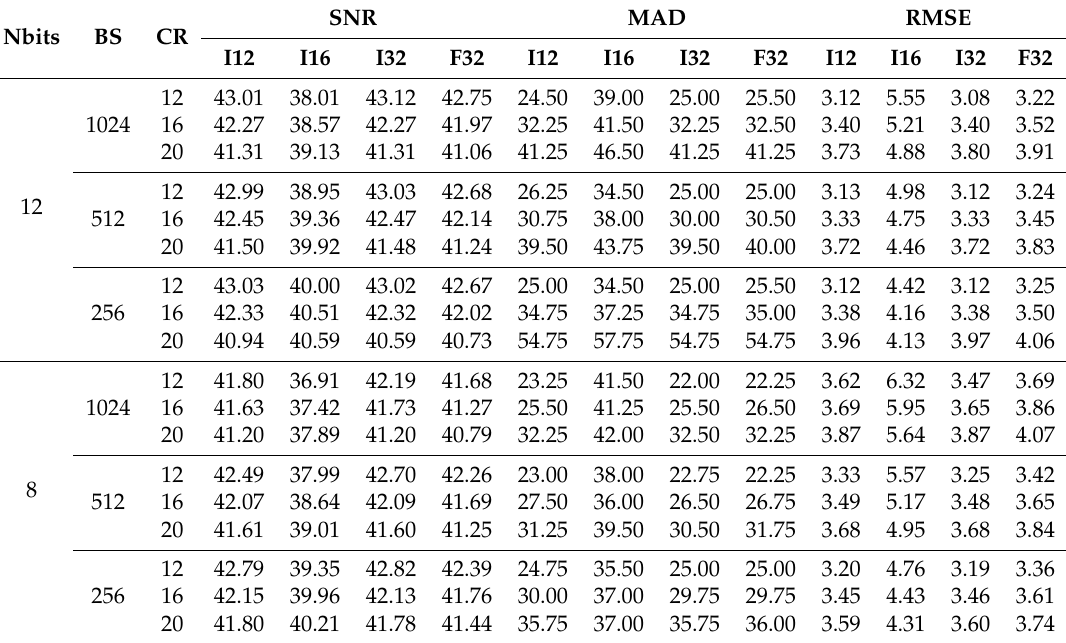
Table 2. Comparison of the compression results for the four versions of the HyperLCA algorithm under study: I12, I16, I32 and